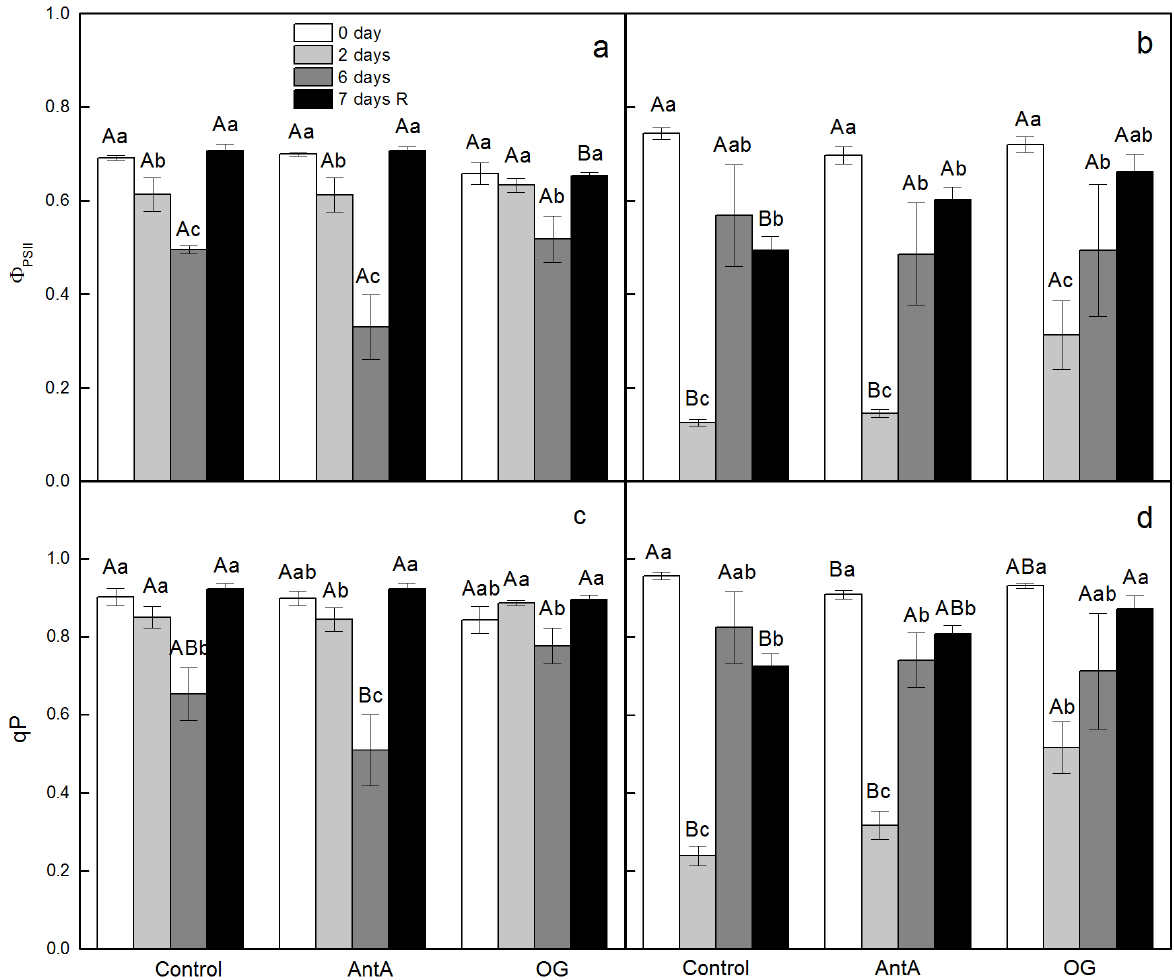
Figure 1. Effect of specific electron transport inhibitors on the effective quantum yield of photo- chemical energy conversion of PSII ( Φ PSII ) ( a , b ), and on the coefficient of photochemical quenching (qP) ( c , d ) of leaf discs from Arabidopsis thaliana wt ( a , c ) and lut2 ( b , d ) plants before start of treatment (0 day), after treatment of plants for 2 or 6 days with low temperature and high light intensity, and after a recovery period at normal conditions (7 days R). Leaf discs were floated either on distilled water (Control) or in the presence of two electron inhibitors - 10 µ M antimycin A (AntA) for protein gradient regulator 5 (PGR5) or 20 µ M octyl gallate (OG) for plastid terminal oxidase (PTOX). Results presented are mean values ± standard error (SE) from three parallel samples of two independent experiments ( n = 6). Different letters indicate significant differences for the respective parameters at p < 0.05 (uppercase for the different treatments (Control, AntA and OG) on a certain day; lowercase for the certain treatment at different time periods (0 day, 2 days, 6 days and 7 days R)).